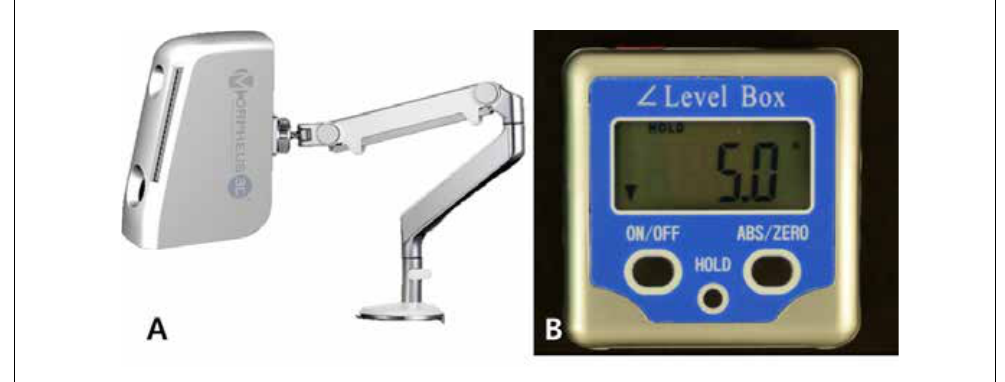
Figure 1. The structured light scanner (Morpheus 3D®) (A), and digital inclinometer (Level Box®) used in this study